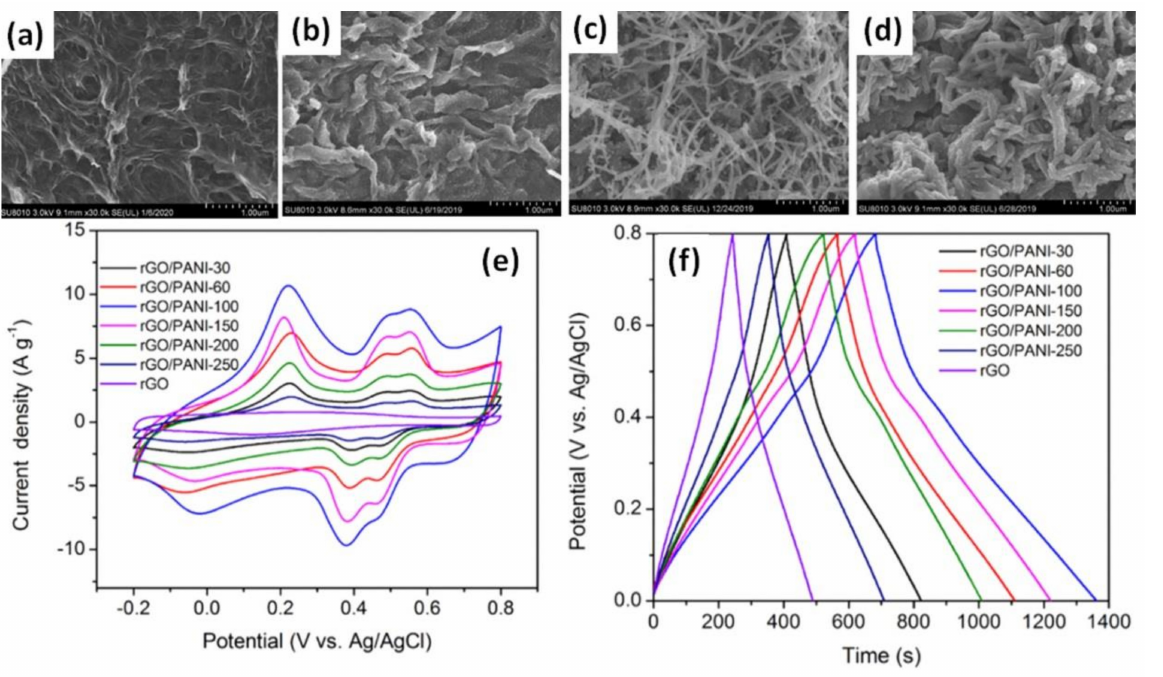
Figure 13. Microstructures of pristine rGO ( a ) and after PANI electropolymerization onto/into rGO hydrogel for 30 s (rGO/PANI-30) ( b ), 100 s (rGO/PANI-100) ( c ) and 200 s (rGO/PANI-200) ( d ) samples deposited. CV curves at a scan rate of 5 mV/s for the rGO and various rGO/PANI electrodes after different times of electropolymerization (30, 60, 100, 150, 200 and 250 s) ( e ). GCD curves at different current densities for rGO/PANI-100 electrode ( f ) (Reprinted from [57], Copyright 2021, with permission of Elsevier).